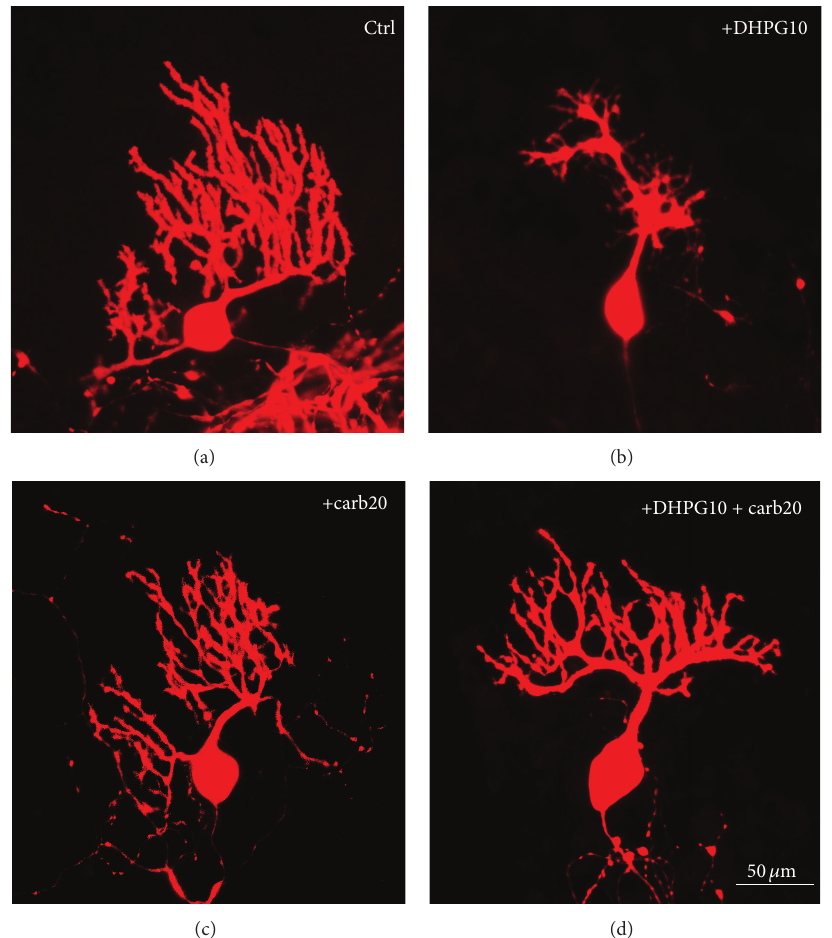
Figure 3: (a–d) Anti-calbindin-stained Purkinje cells from different pharmacological treatment. (a) Purkinje cells from untreated control cultures have a well-defined and profuse dendritic arbor. (b) Purkinje cells from slice culture treated with 10 𝜇 M DHPG have a dendritic arbor greatly reduced in size with an absence of the distal dendritic branches. (c) Purkinje cells from carboxyeosin-treated cultures have a dendritic arbor smaller compared to untreated control but larger compared to DHPG treated cultures. (d) Cotreatment with 20 𝜇 M carboxyeosin provides a partial rescue of the distal dendritic branches of the Purkinje cells. The size of the dendritic arbor is larger compared to DHPG treatment alone. Scale bar 50 𝜇